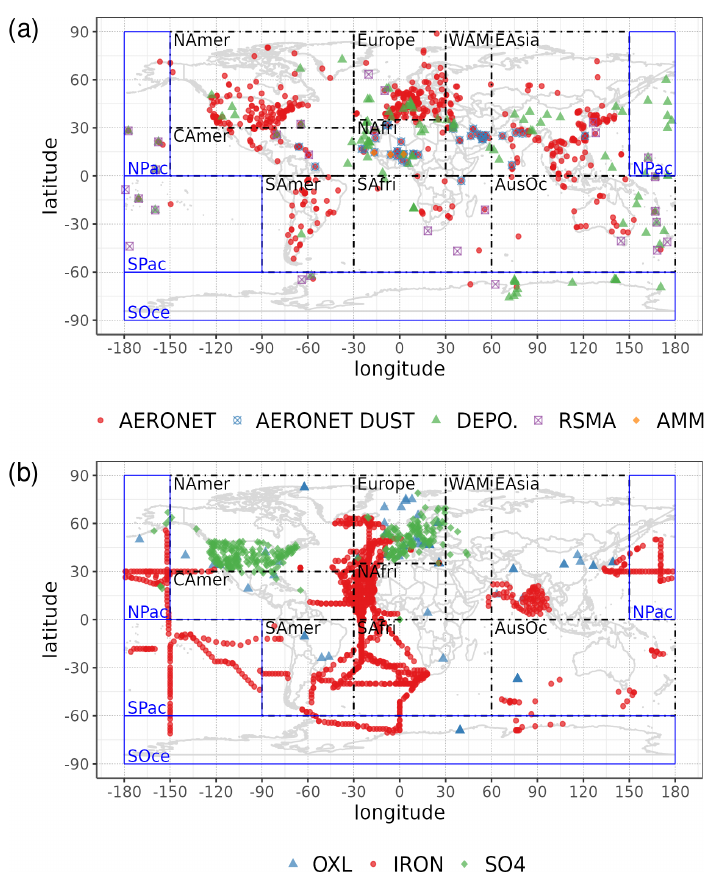
Figure 1. Site location map of observations (a) for AOD (AERONET, red dots; AERONET-DUST, blue squares), dust surface concentration (RSMAS, purple squares; AMMA, orange diamonds), and dust deposition rates (several sources compiled in Albani et al.,2014, green triangles) and (b) for surface oxalate (OXL, blue triangles), surface sulfate (green diamonds), and cruise aerosol Fe concentrations (red